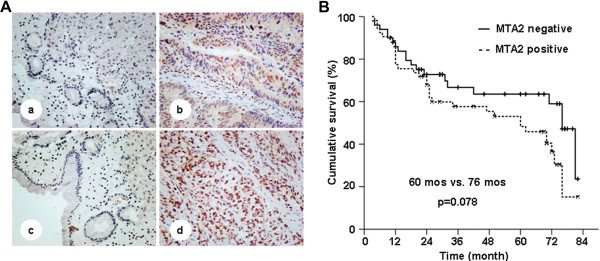
MTA2 in paired mucosa beside tumor and tumor tissues, and survival curve of patients. A, MTA2 expression in paired gastric mucosa beside tumor and tumor tissues from two patients (a, b and c, d) were detected by IHC (×100). B, Patients with MTA2 positive expression had a shorter median overall survival than those with MTA2 negative (60 mos vs. 76 mos, p = 0.078).